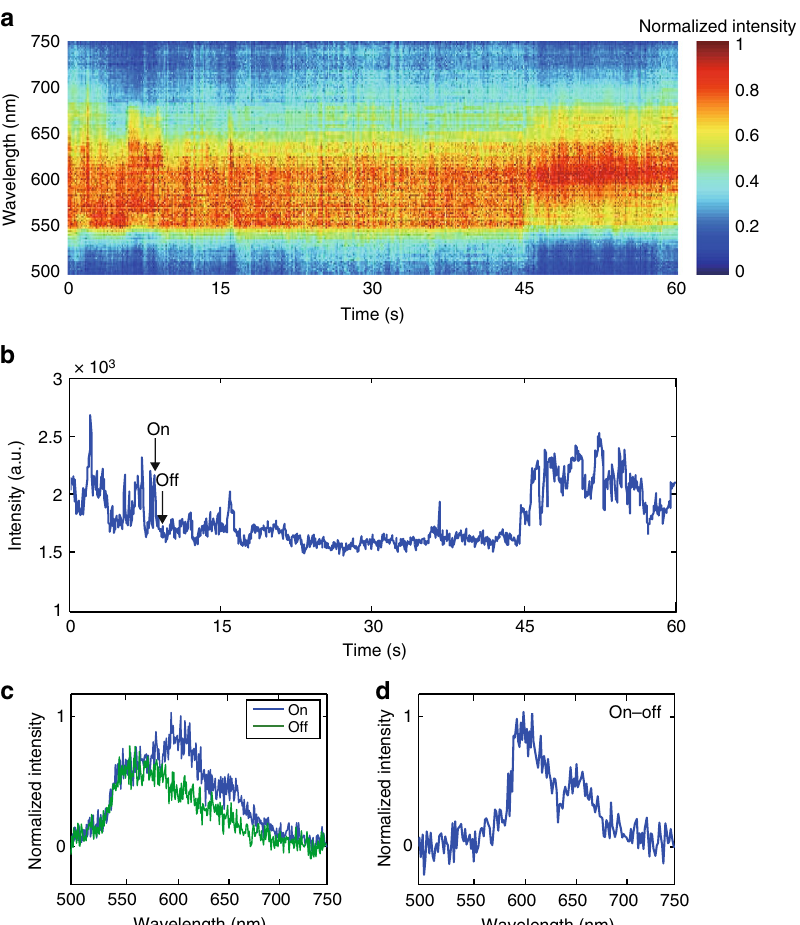
Fig. 1 Single-particle spectrum and fl uorescence intensity trajectory of a F8BT CPN. a Stacked single-particle fl uorescence spectra showing changes over time. The shifts in the spectra can be correlated with blinking events in the corresponding fl uorescence intensity trajectory shown in plot ( b ). b The corresponding fl uorescence intensity trajectory exhibiting pronounced blinking behavior. c , d The spectra of c on and off states, d on – off state. For the on – off spectrum plot, two-pixel binning along the X axis (wavelength) was performed to reduce